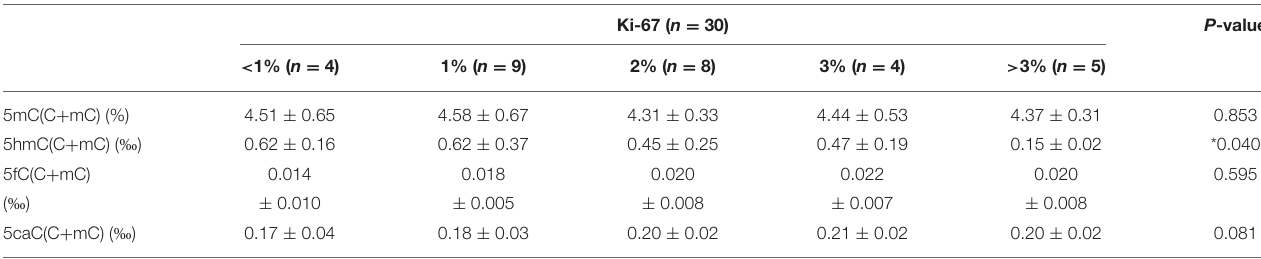
TABLE 2 | Relation between Ki-67 index and 5mC, 5hmC, 5fC, and 5caC levels. Ki-67 ( n = 30) P